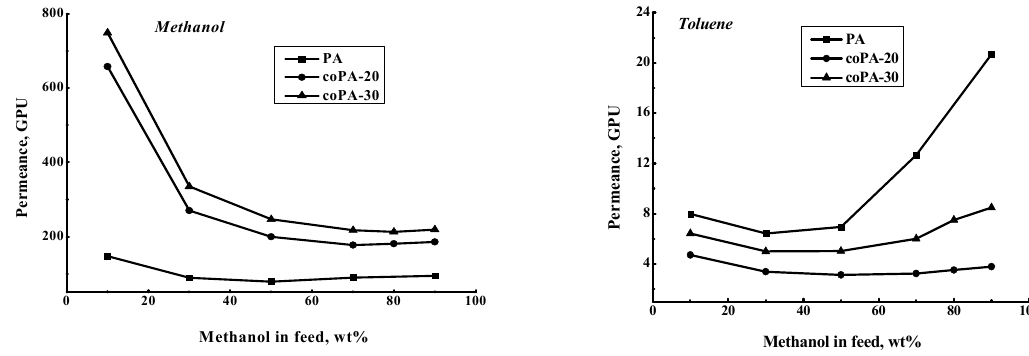
Figure 8. Dependence of methanol and toluene permeance on methanol concentration in the feed, 20 ◦ C.